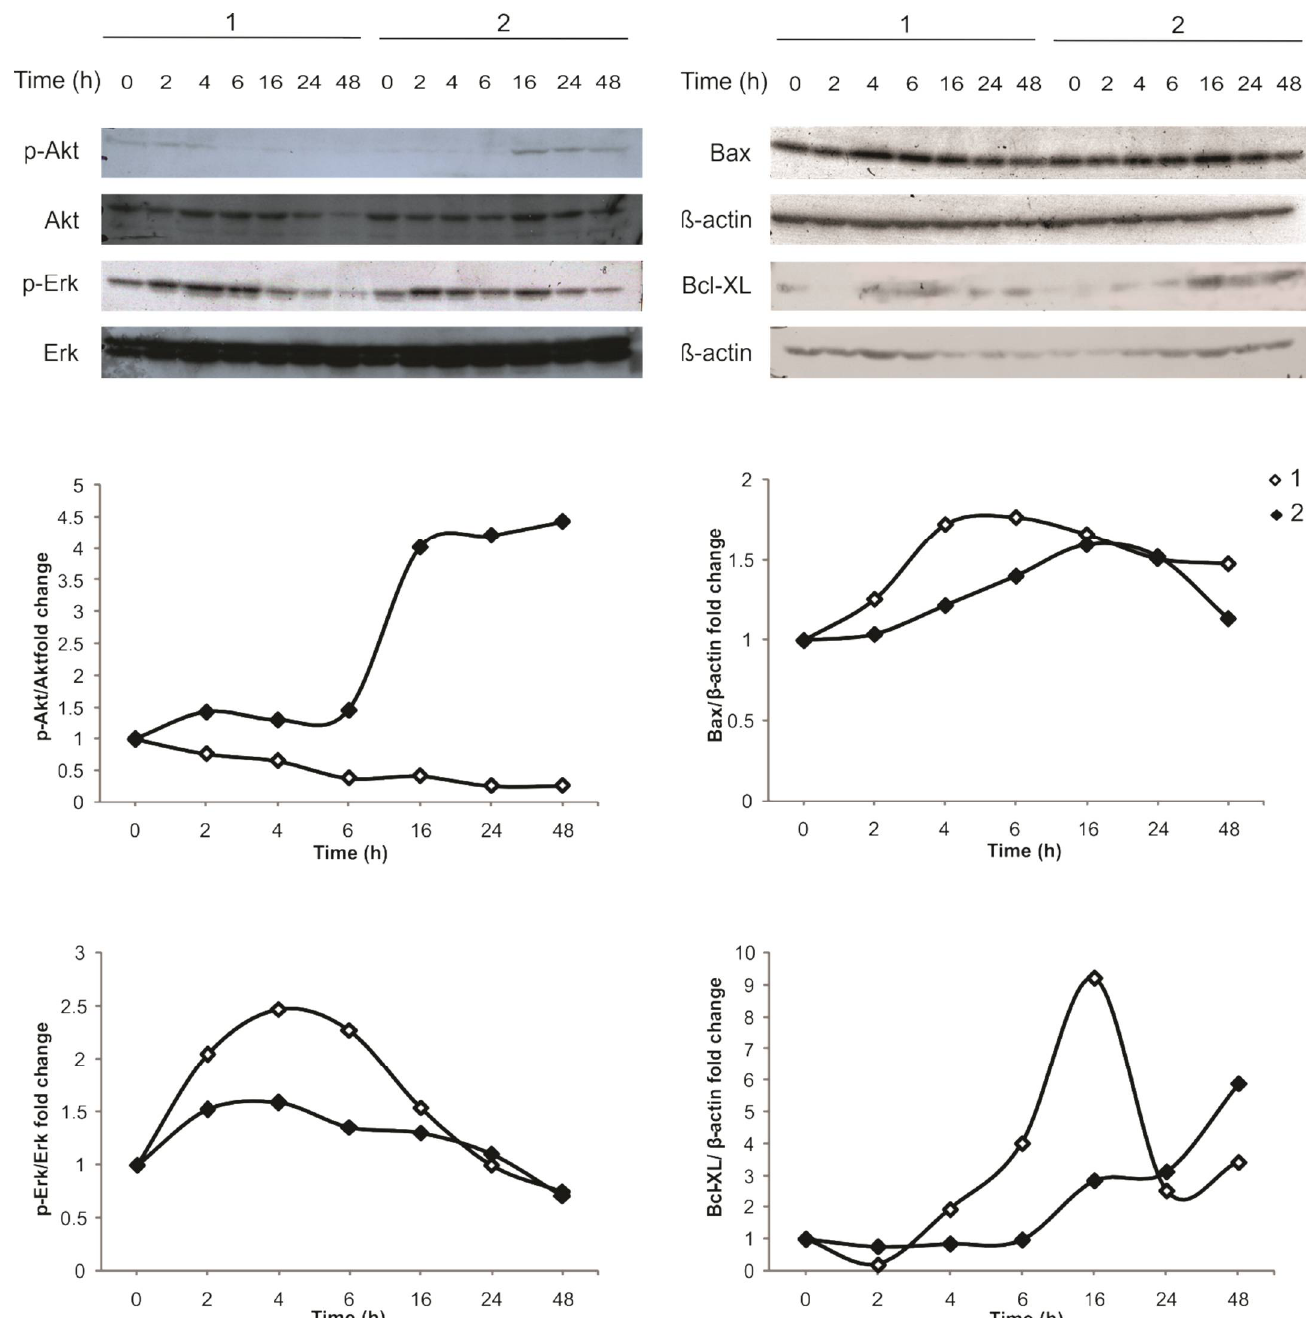
Figure 3. Compound 1 activates MAPK signaling, and compound 2 activates the PI3K/Akt pathway. Colon carcinoma cells were treated with Rev-5901 analogs 1 and 2 for indicated time points, and the expression was analyzed by Western blot. Densitometry analysis is presented as a fold change relative to control. One representative experiment out of three is shown.